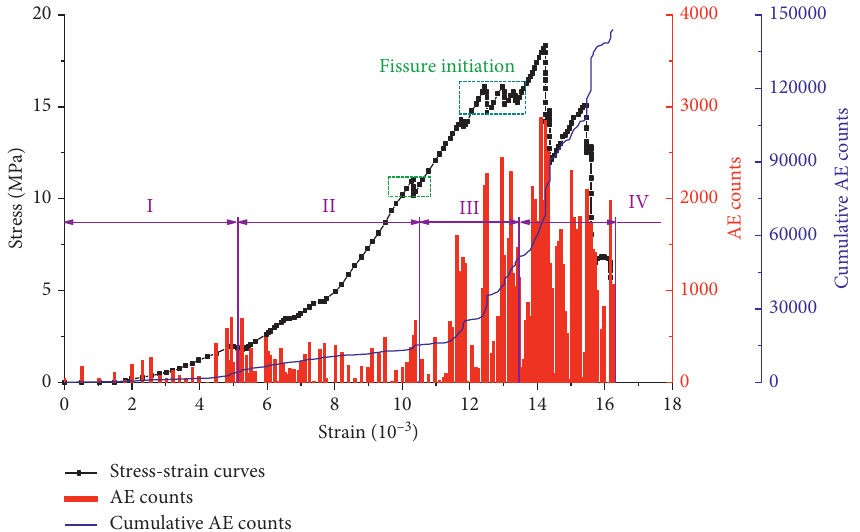
Figure 6: Stress-strain curve and acoustic emission monitoring curve of coal sample after immersion in acidic